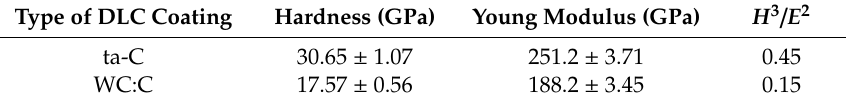
Table 1. Summary of the experimental data derived from the nanoindentation curves including the resultant hardness ( H ), Young modulus ( E ), and their relationship H 3 / E 2 . DLC—diamond-like carbon. Type of DLC Coating